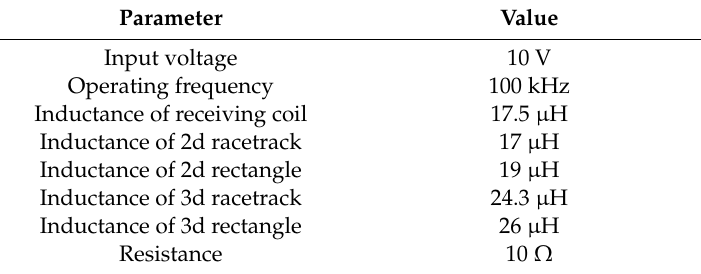
Table 5. Experiment related parameters.